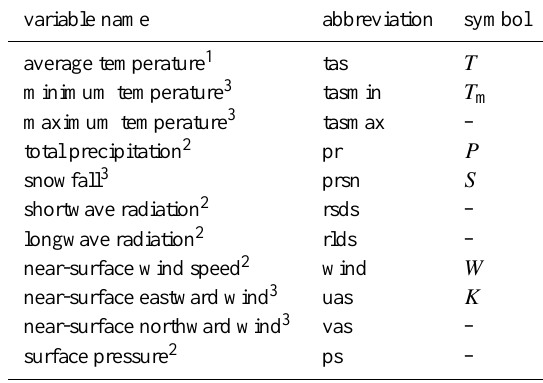
Table 1. Bias-corrected variables in the ISI-MIP